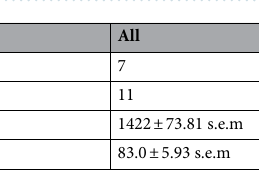
Table 1. Comparison of nuclear countings from antennal lobe of female and male migratory locusts. Nuclei of 11 antennal lobes (AL) from seven individuals were analyzed. Nuclear counting comprises PN, LN, and glia. Mann–Whitney tests revealed, that nucleus counts of all cells and GABAergic cells was not significantly different between male and female locusts ( p = 0.0823; p = 0.5368